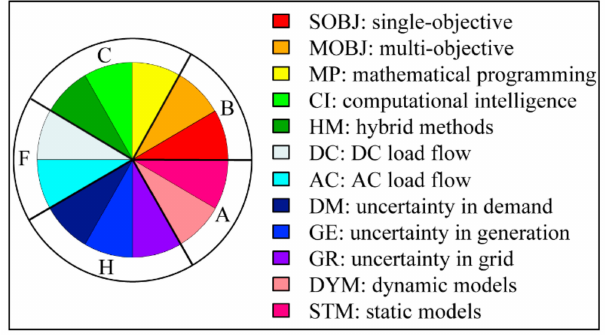
Figure 7. Attributes considered with their respective associated color.